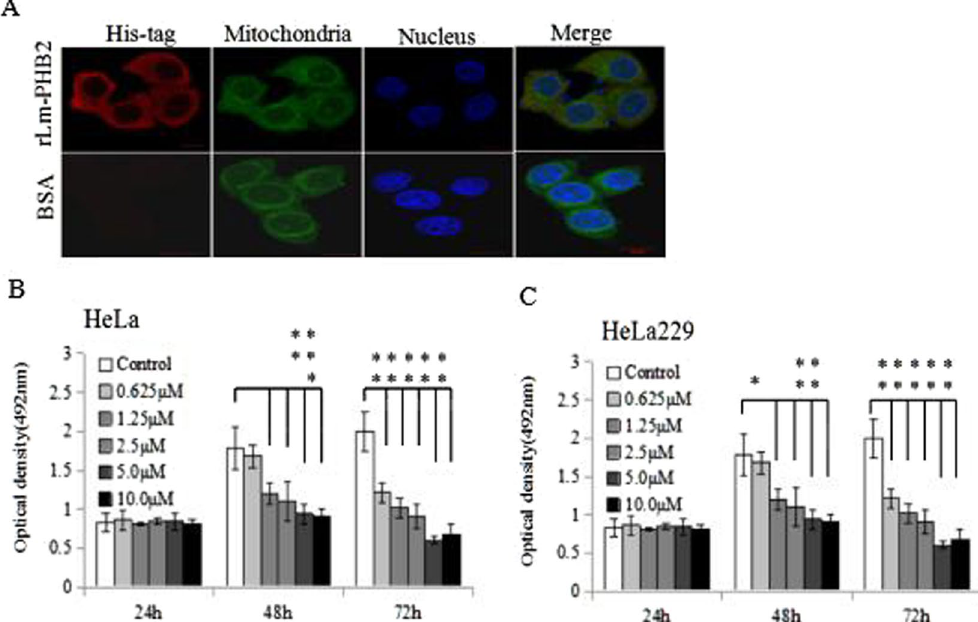
Figure 1. Effect of purified rLm-PHB2 on the proliferation of human cervical cancer cells. ( A ) Confocal microscopic images of rLm-PHB2 protein entering into HeLa cells and localizing in cytoplasm. rLm-PHB2 culture 24 h were immunostained with His-tag antibody (Red). Mitochondria were stained with MitoTracker (Green), and nucleus were stained with Hoechst33258 (bule). Scale bar, 10 μ m. ( B , C ) HeLa and HeLa 229 cells were treated with PBS or different concentrations of purified Lm-PHB2 (0.625 μ M, 1.25 μ M, 2.5 μ M, 5.0 μ M and 10.0 μ M) at 37 °C for 24 h, 48 h or 72 h and cell viability was determined by the MTT assay. Data are the means ± SDs from three experiments, each carried out in triplicate. ‘ * ’ and ‘ ** ’ indicate significantly different from control cells (not treated with Lm-PHB2) at the P < 0.05 and P < 0.01 levels,